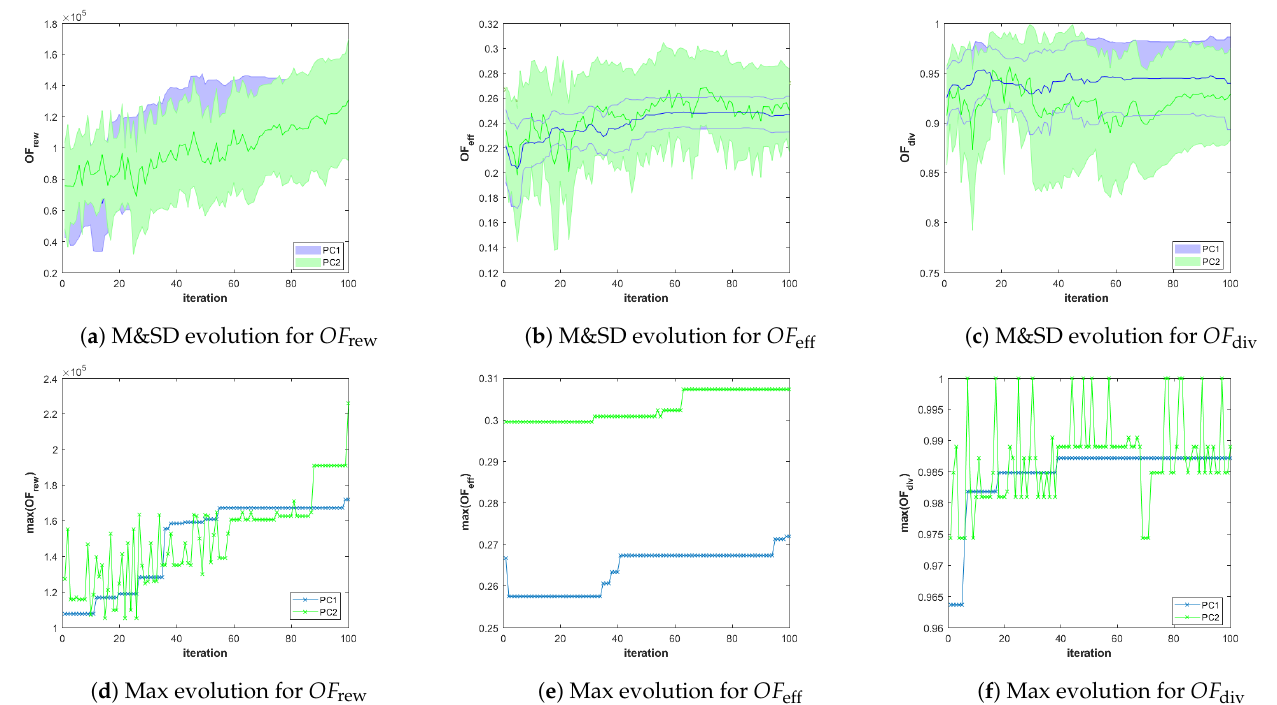
Figure 13. Evolution graphics of the OFs of the feasible solutions of the best Pareto front for SC3. The top row of graphics shows the evolution of the mean and standard deviation (M&SD) of each OF, while the bottom row shows the evolution of the best (Max) value of each OF.